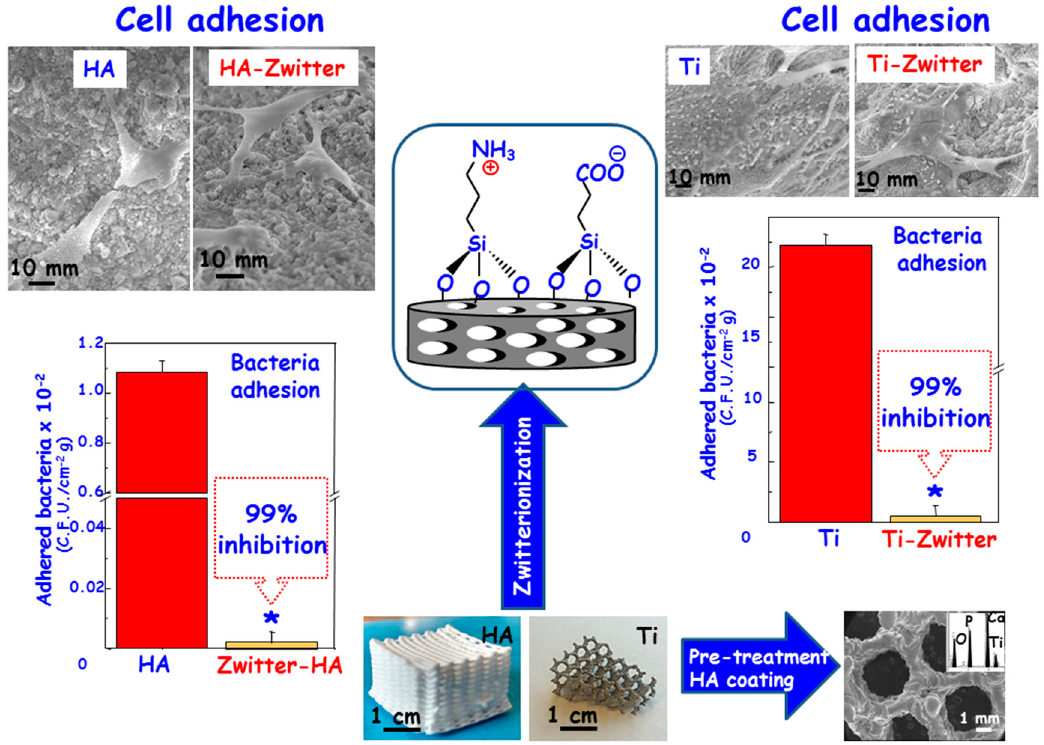
Figure 4. Zwitterionization of different biomaterials in clinical use by grafting of carboxyethylsilanotriol sodium salt (CES) and aminopropyltriethoxysilane (APTES) onto the surface of these biomaterials. Left: Pure HA three-dimensional (3D) Rapid Prototyping (RP) scaffolds. Right: Electron Beam Melting (EBM) Ti6Al4V 3D scaffolds.